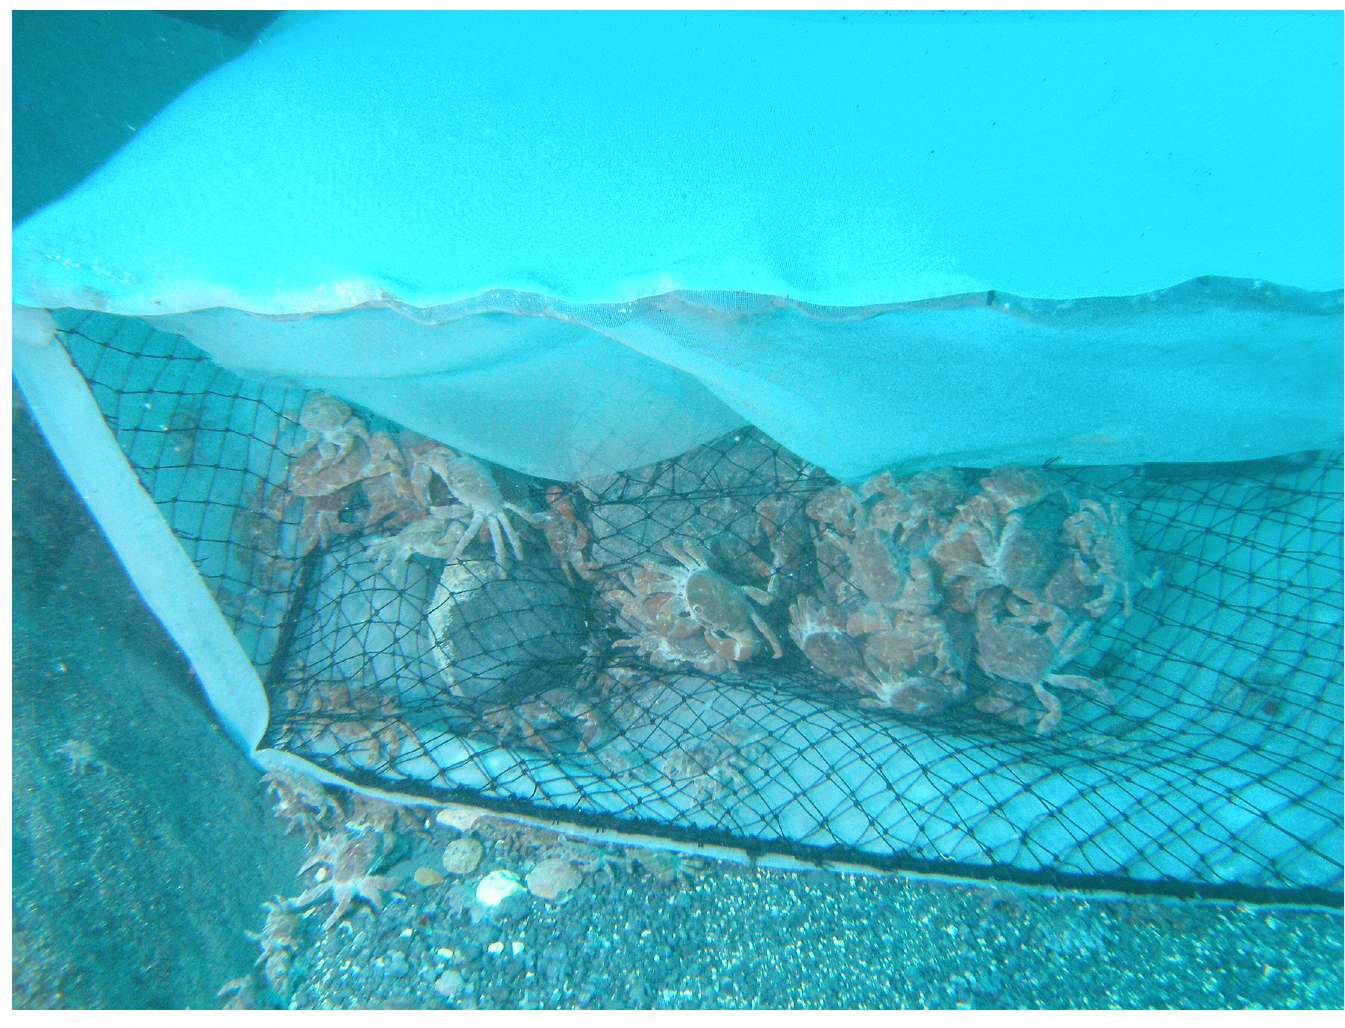
Fig 2. Map of the study area (upper) and sampling locations (lower) around Kueishan Island during August 2011 to September in 2012. The grey area indicates the sampling station location.